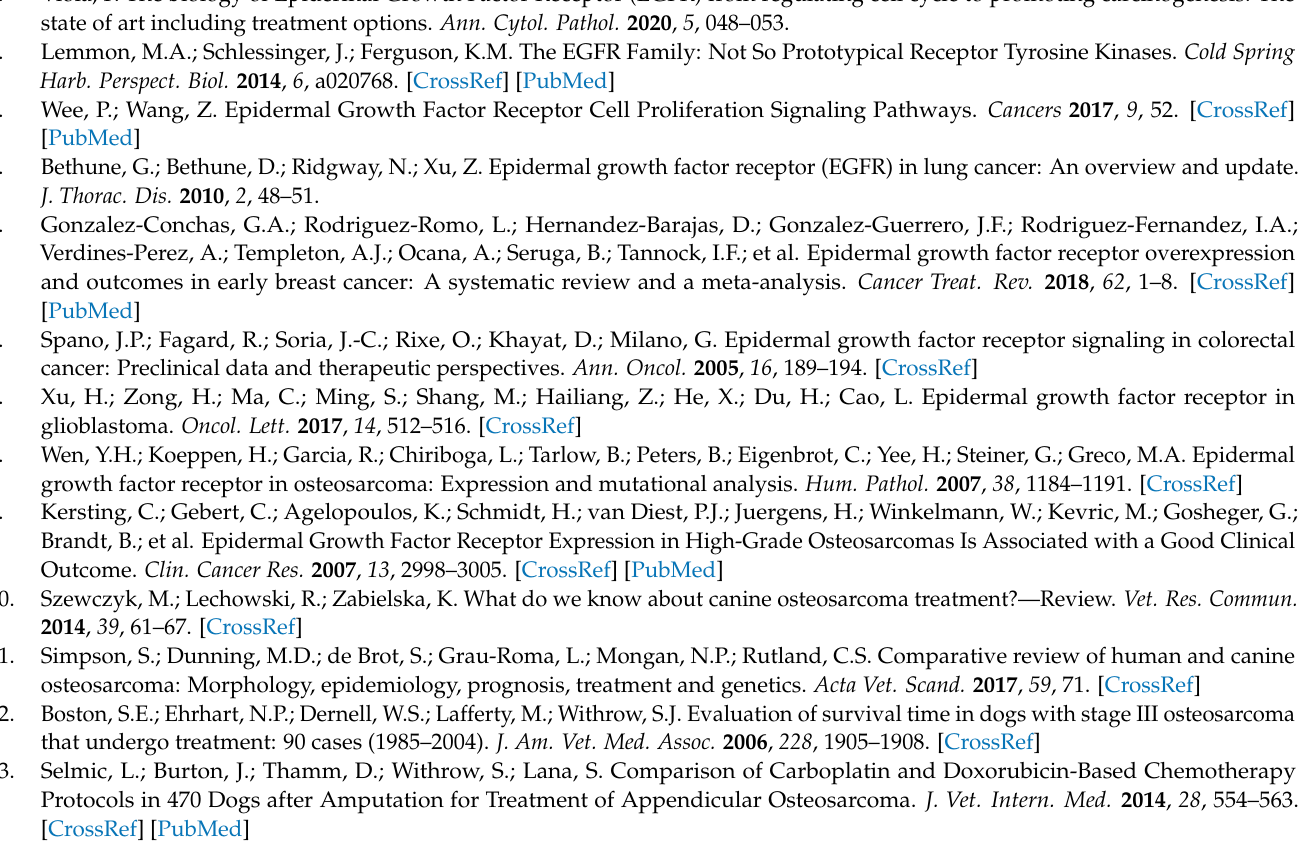
EGFR-negative cells elicited., Figure S2: E134Bf did not inhibit the cell growth of A-72 stimulated by EGF., Figure S3: Ki-67 staining in the xenograft tumor